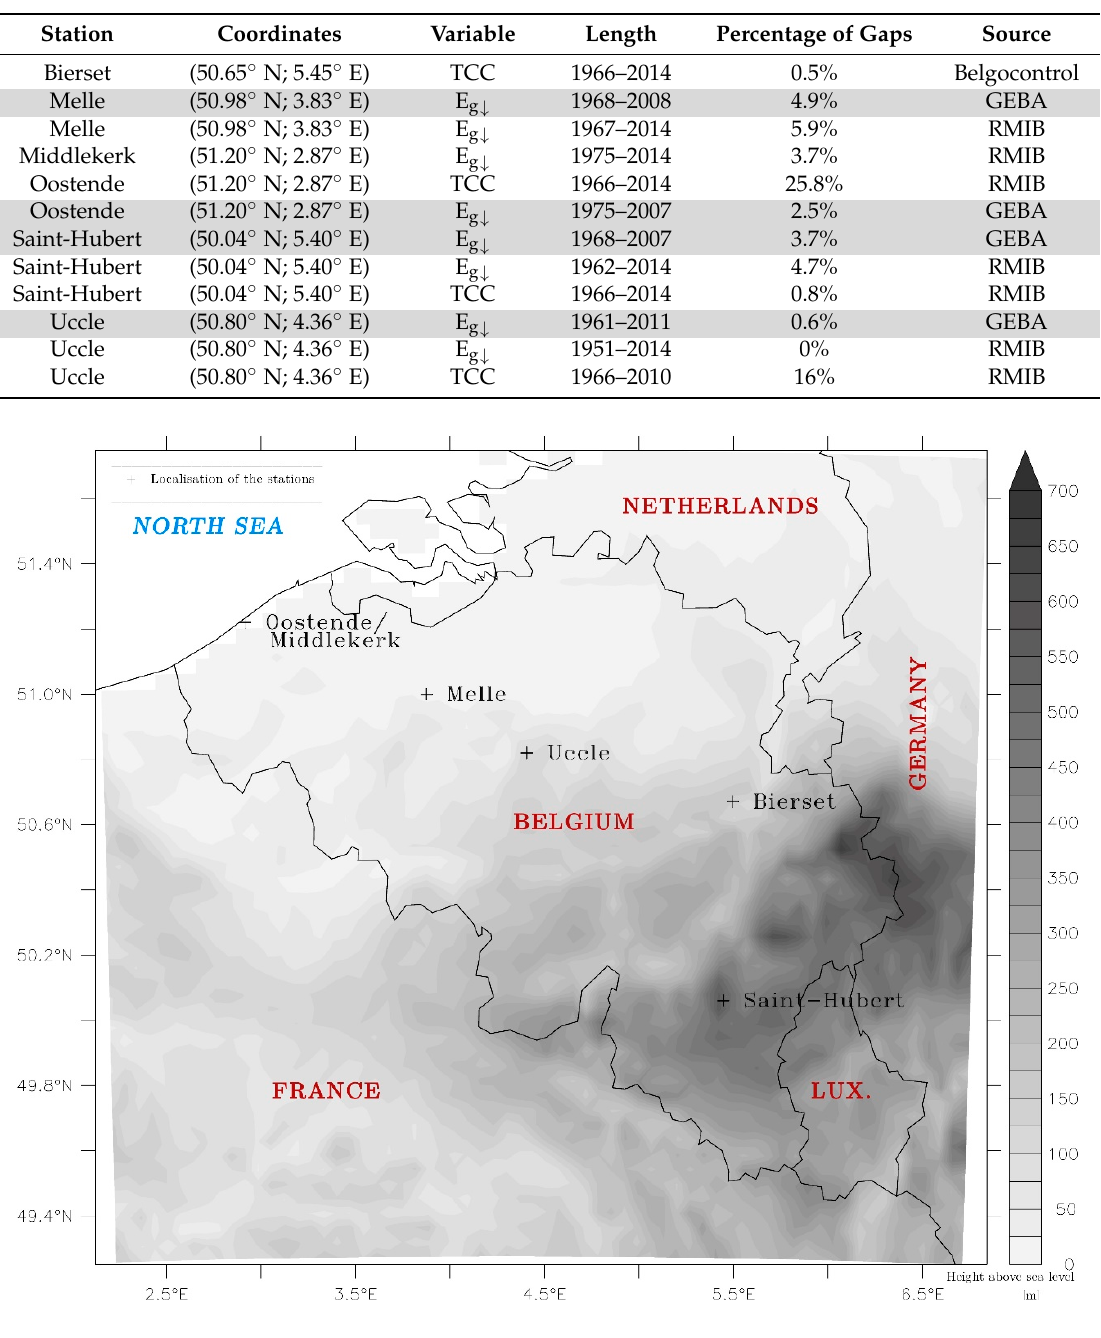
Figure 1. Orography of the study area and location of the ground-based stations used in this